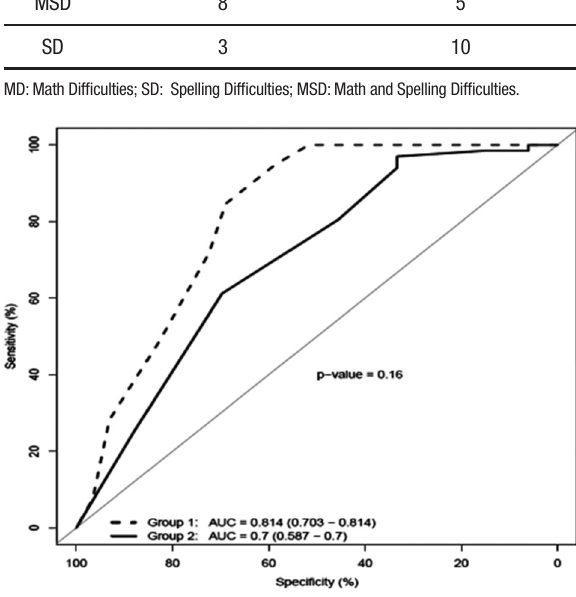
Figure 2. Diagnostic accuracy of the MMC for distinguishing between children with and without learning difficulties.